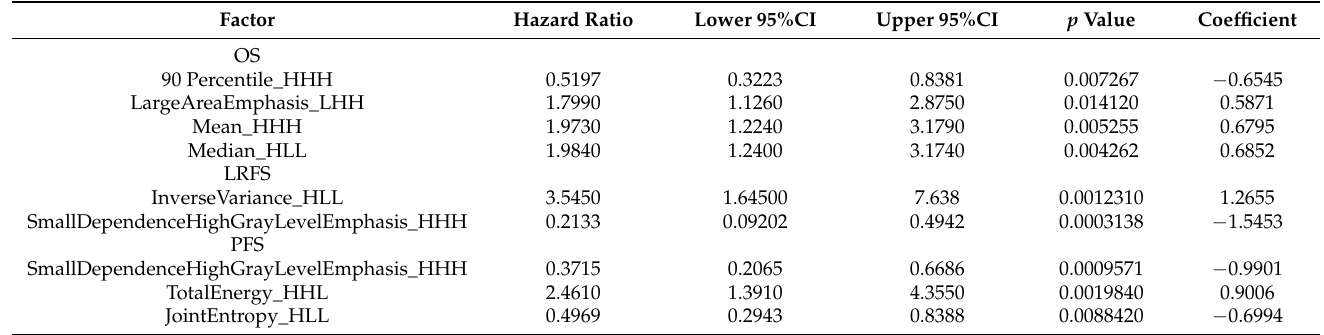
Table 3. Multivariate analysis of radiomic factors using the Cox proportional hazards regression model with the stepwise